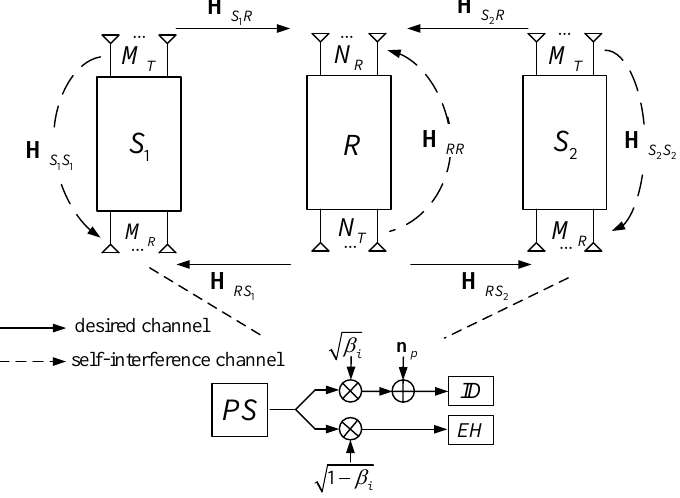
Figure 1. The system model of the multi-input multi-output (MIMO) full-duplex (FD) bidirectional wireless sensor network (BWSN) with energy harvesting